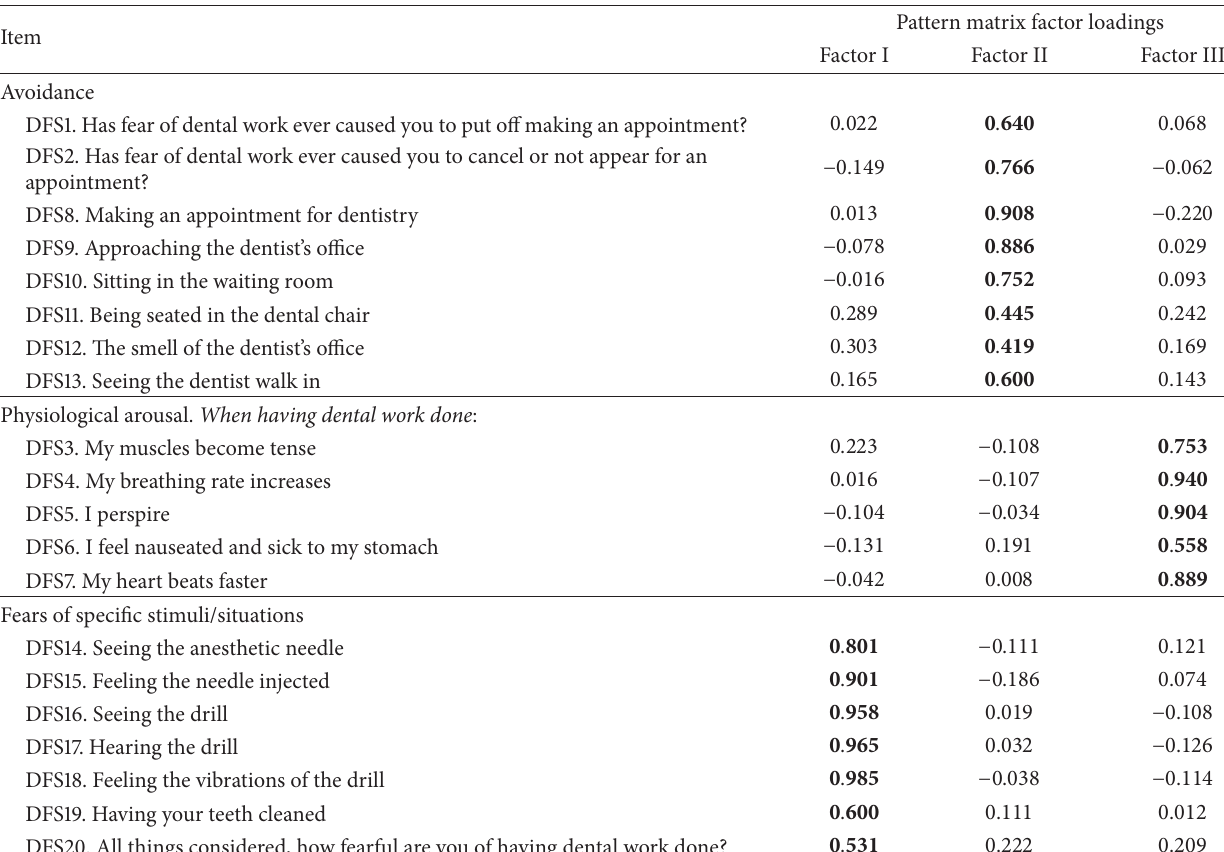
Table 2: Structure loadings for the three-factor solution with Promax rotation and correlations of the Dental Fear Survey (DFS) with each item.